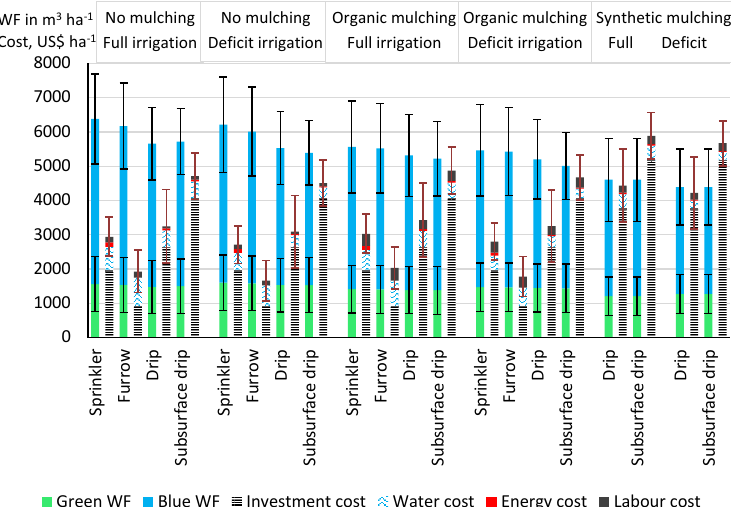
Figure 3. Average WF per area (m 3 ha − 1 ) for maize production and average annual costs associated with 20 management packages. The whiskers around WF estimates indicate the range of outcomes for the different cases (different environments, hydrologic years and soil types). The whiskers around cost estimates indicate uncertainties in the costs. WF estimates are split up into blue and green components; costs are split up into investment, water, energy and labour costs.